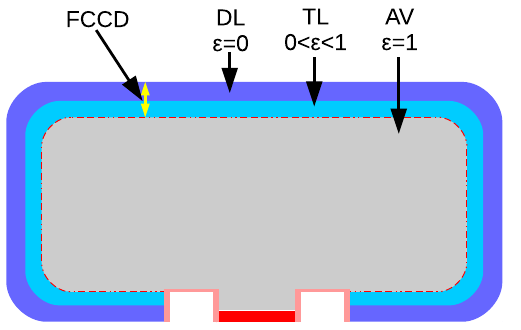
Fig. 9 Conceptual representation of the full charge collection depth (FCCD)andactivevolume(AV)ofthe Gerda PhaseIIBEGedetectors. The charge collection efficiency in the dead layer (DL), transition layer (TL) and AV is denoted with (cid:7) . Moreover, the boron (B) implanted p+ contact is depicted in red, while the inactive wrapped around lithium (Li) diffused n+ contact is drawn in blue. The insulating ring between the two electrodes is shown in pink. For further details see the